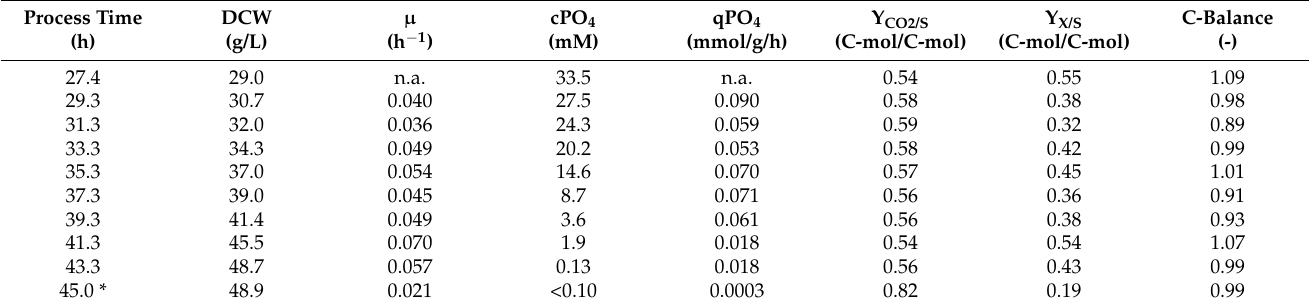
Table 7. Strain physiological parameters of E. coli W3110 harboring the phoA expression system at different extracellular PO 4 concentrations.